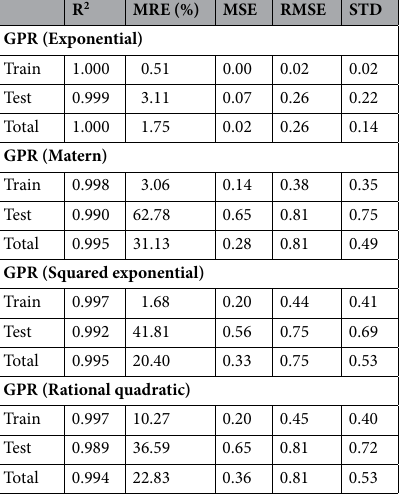
Table 1. The statistical parameters of proposed GPR